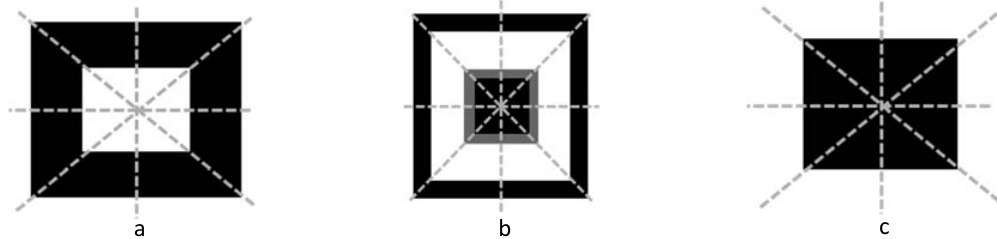
0.00%10.00%20.00%30.00%40.00%50.00%60.00% Fig. 7: Evolution of the share of open, closed, and roofed spaces in the total area of Aleppo mosques Fig. 8: Structural evolution of types of space in mosques. a- Introverted pattern, b- introverted-extroverted pattern, c- Extroverted